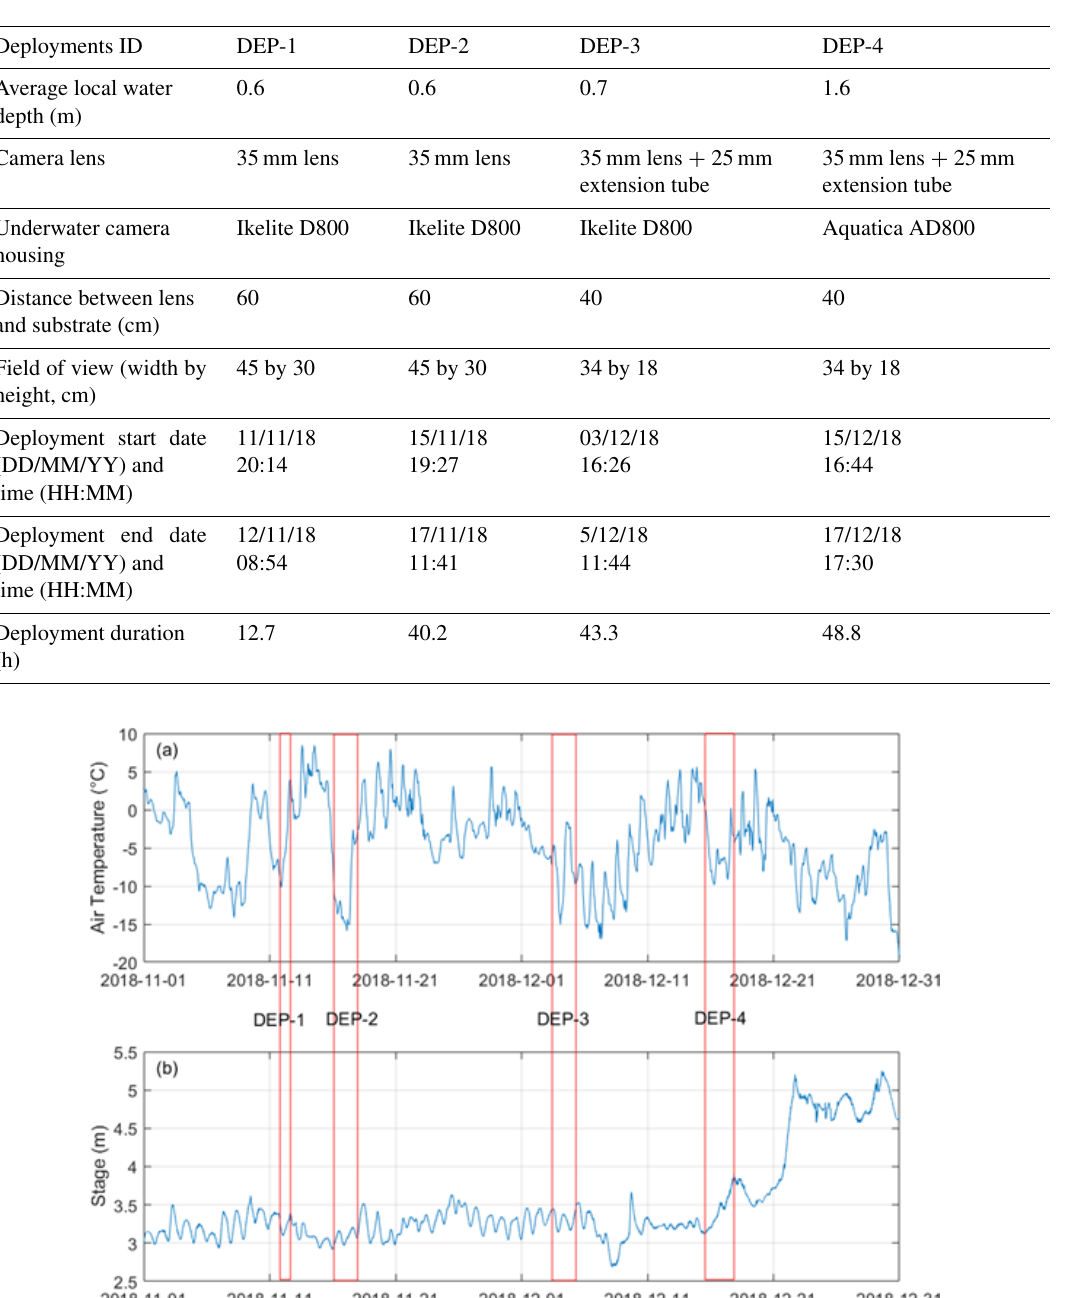
Table 1. Summary of field deployments and camera settings.